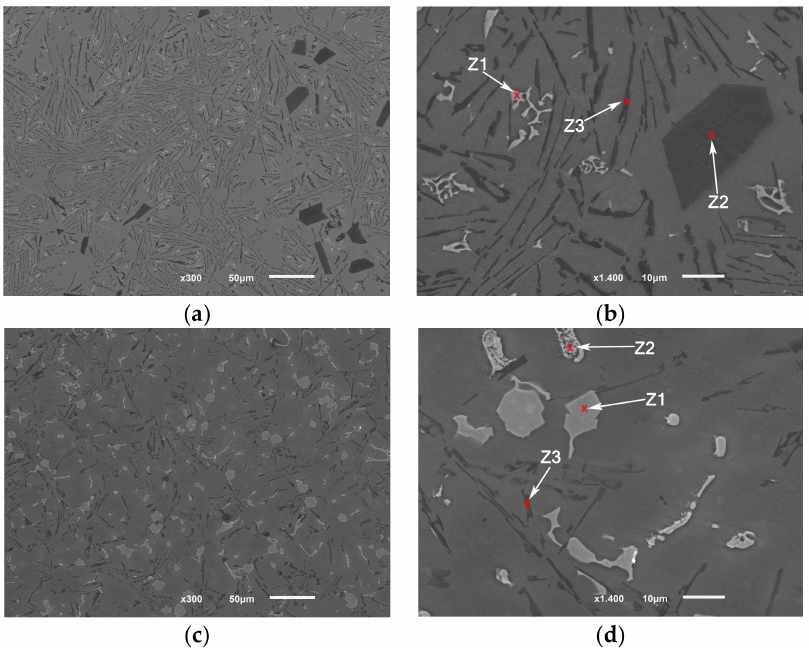
Figure 2. SEM images (SEI) of Al-13Si and Al-9Si-3Cu filler alloys degassed by Argon. All filler alloys were prepared without USV treatment: ( a , b ) Al-13Si, where Z1 is a script-like Al 15 ( Fe , Mn )